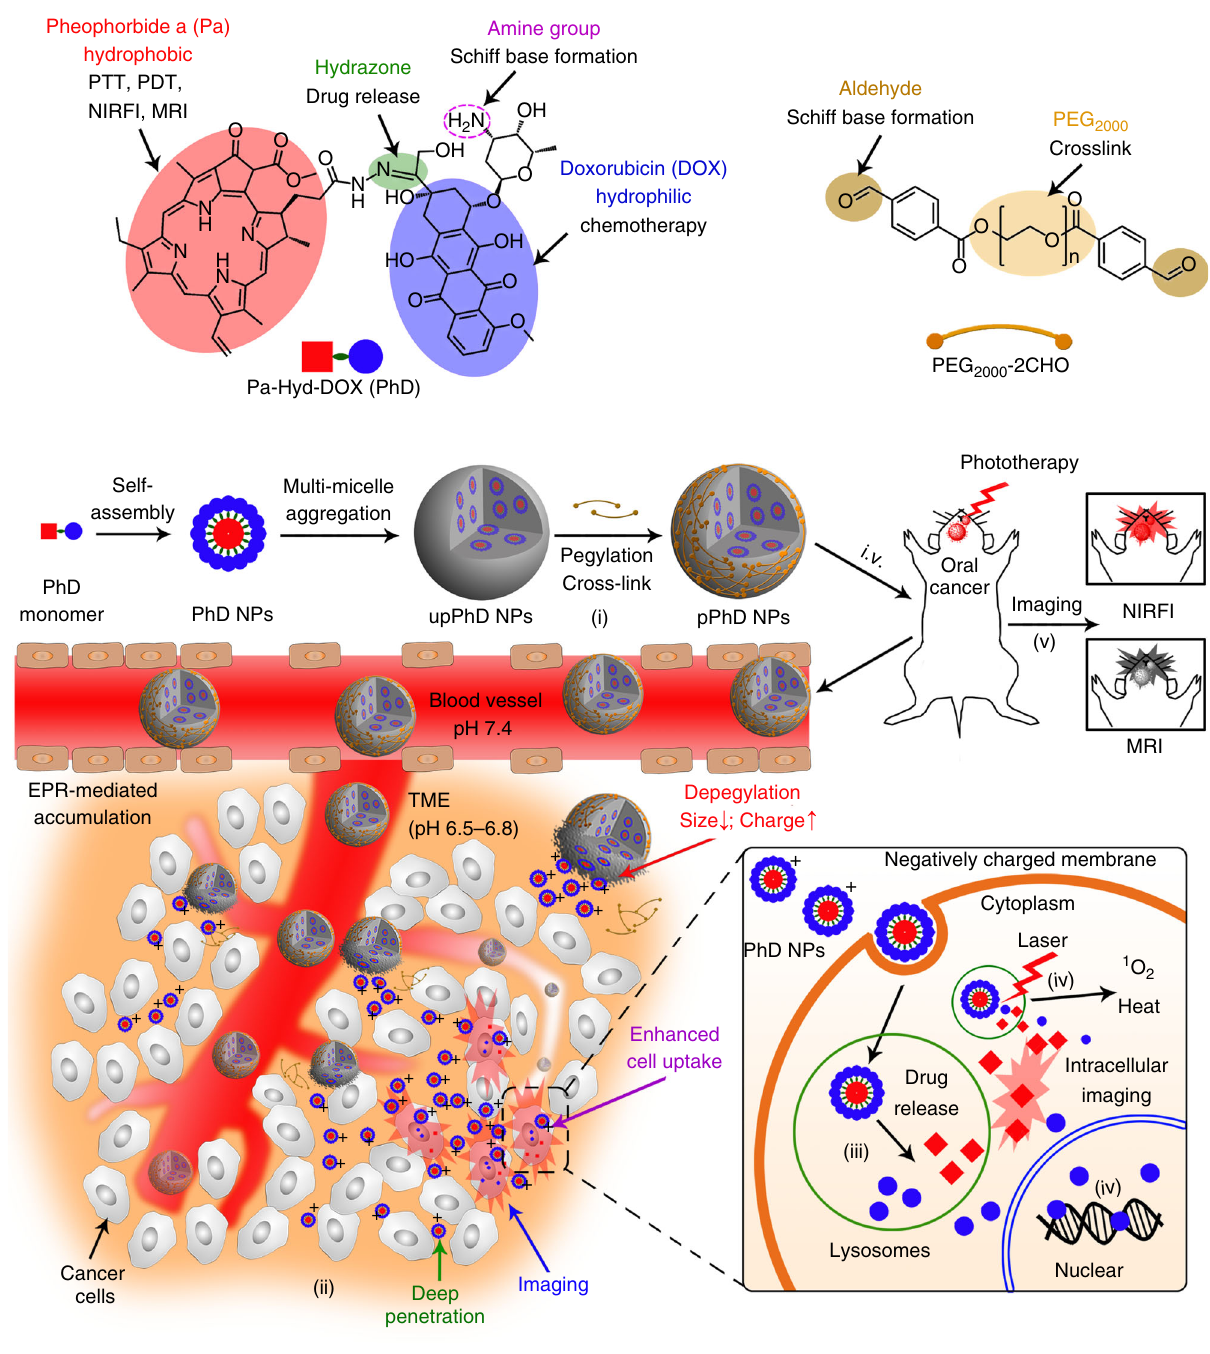
Fig. 1 Schematic illustration of the Trojan-Horse nanoparticles. Image illustration of the functionalities of the building blocks and construction of the Trojan- Horse nanoparticles (pPhD NPs), and their capabilities to overcome a series of biological barriers through TME responsiveness, de-PEGylation/cross- linkage, transformability, superior penetrations, enhanced cell internalisation, intracellular drug release for multimodal imaging and trimodality therapies. Abbreviations: PDT photodynamic therapy, PTT photothermal therapy, NIRFI near-infrared fl uorescence imaging, MRI magnetic resonance imaging, TME tumour microenvironment, Red square denotes Phy, and blue circle denotes DOX, PhD pheophorbide a-hydrazone-doxorubicin, upPhD NPs